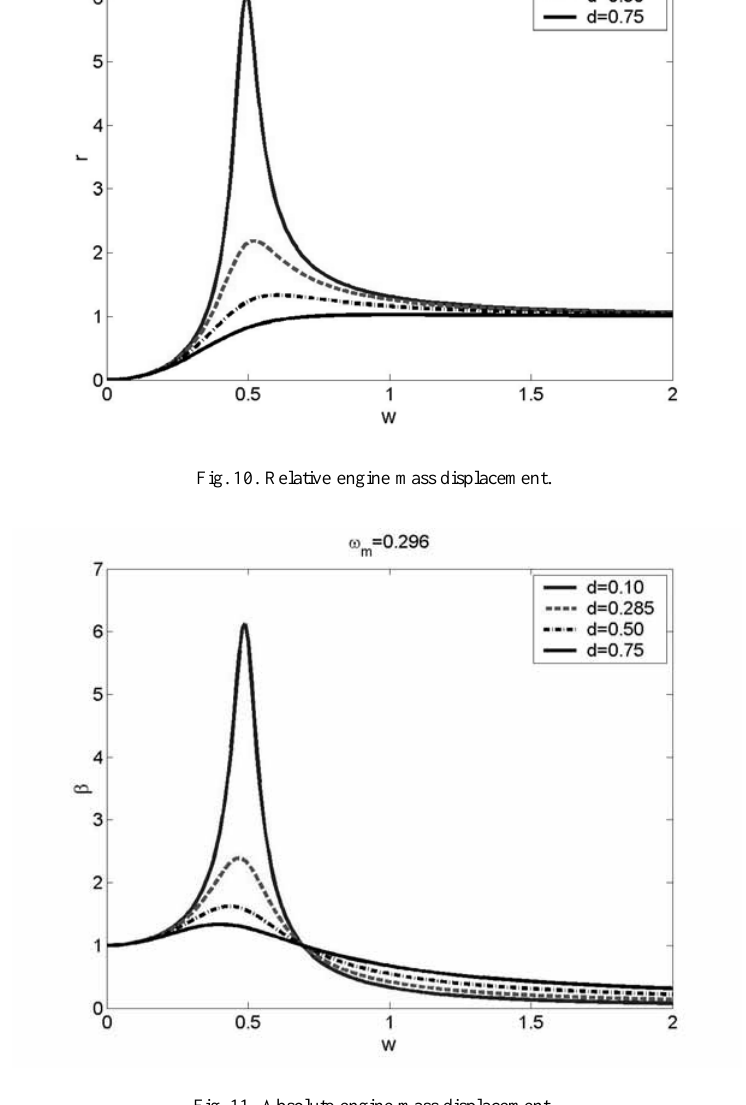
Fig. 11. Absolute engine mass